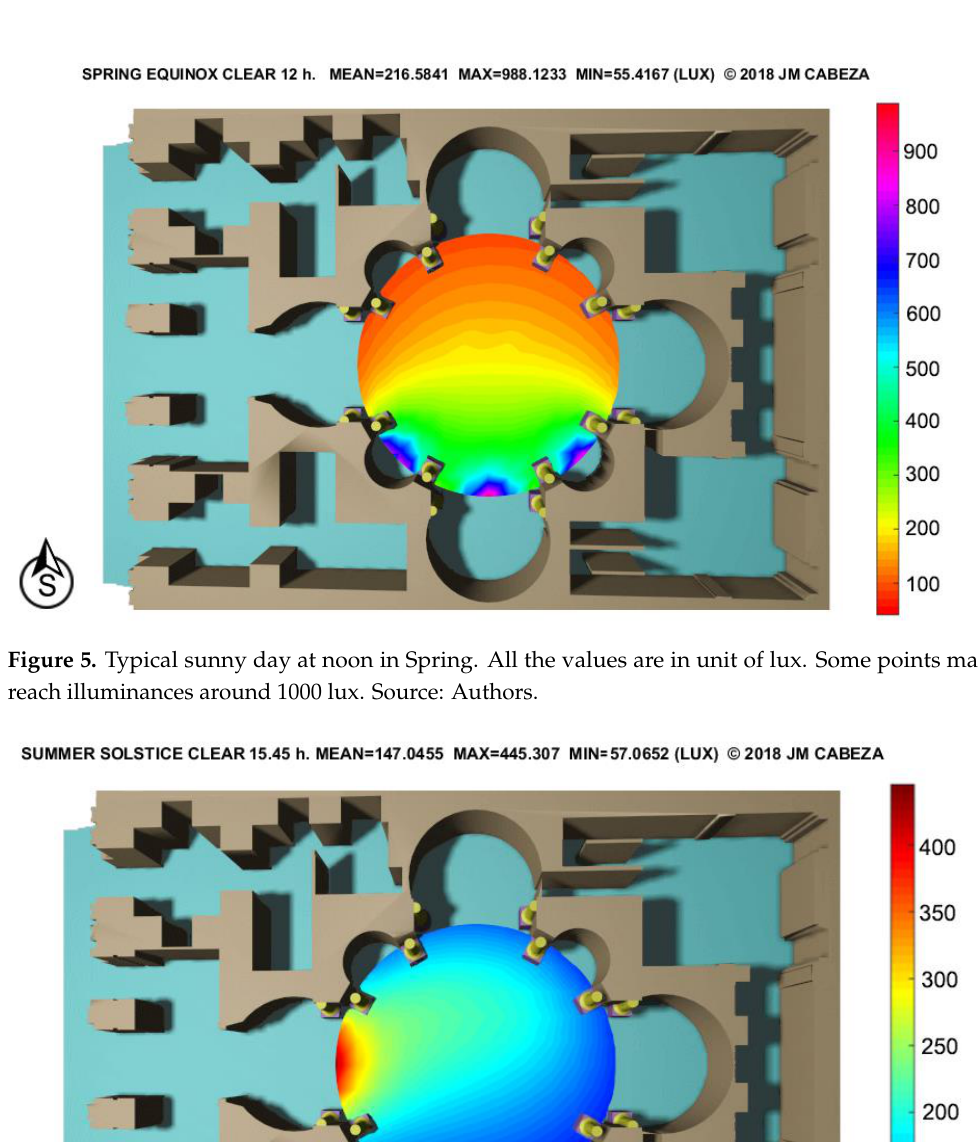
Figure 5. Typical sunny day at noon in Spring. All the values are in unit of lux. Some points may reach illuminances around 1000 lux. Source: Authors.